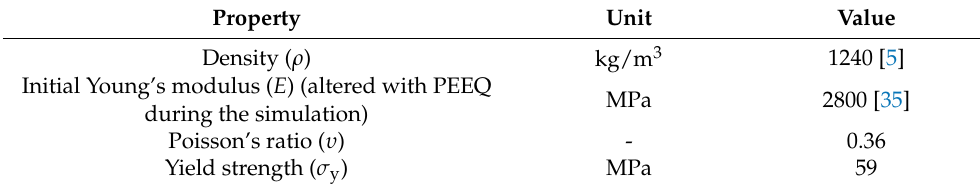
Table 1. Mechanical properties of the PLA applied in the numerical